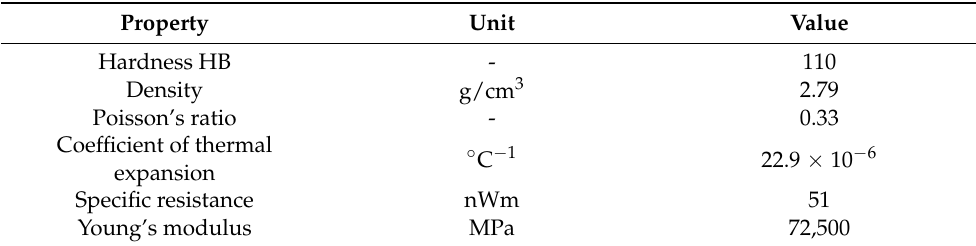
Figure 3. ( a ) dimensions (in mm) of the cylindrical die used in the experiments and ( b ) method of attaching strain gauges to the die surface. Table 1. Selected physico-mechanical properties of the EN AW-2017 aluminium alloy.